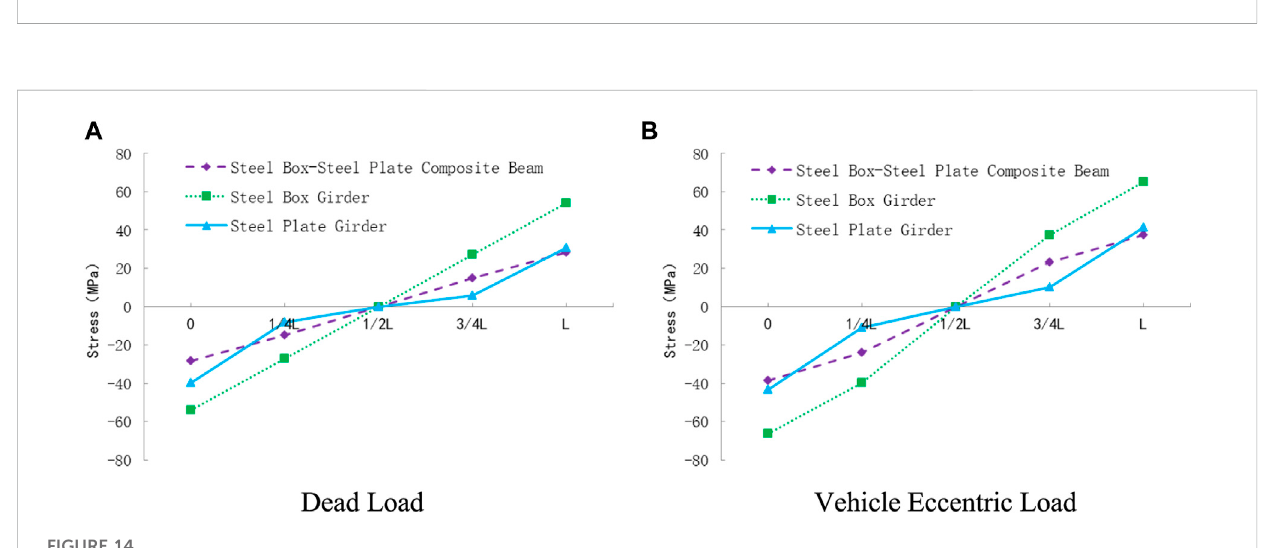
Comparison of shear stress of curved